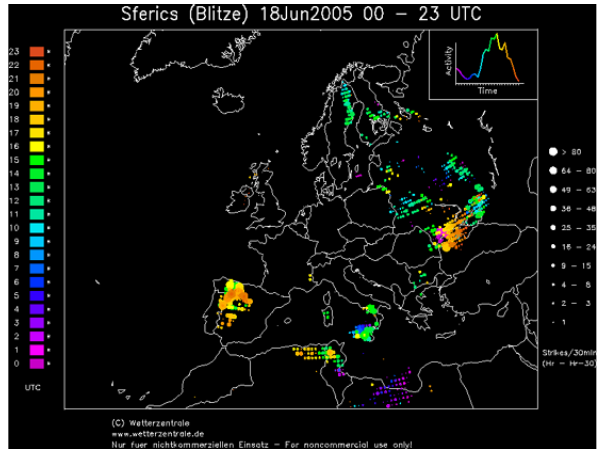
Fig. 13. Date: 18 June 2005, CL4. Spatial, temporal and intensity distribution of lightning